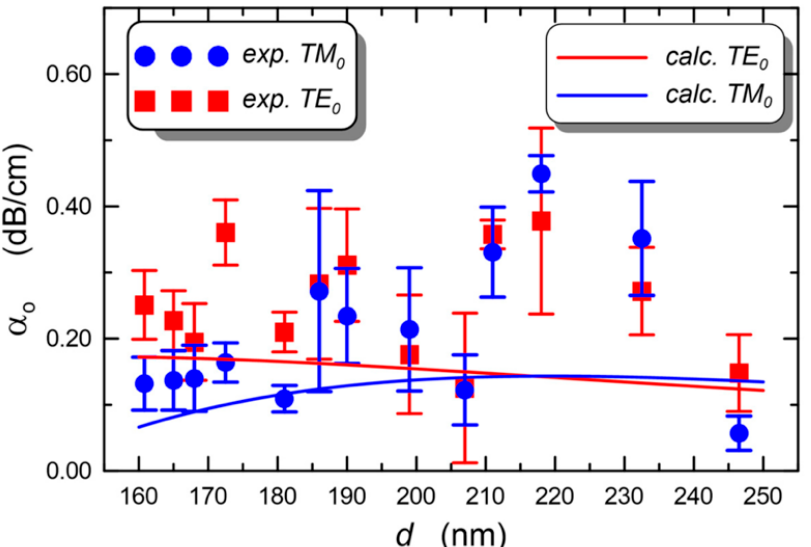
Figure 5. Experimental and calculated loss of fundamental TE and TM modes at 677 nm propagating in a silica-titania sol–gel single-mode waveguide deposited onto a BK7 substrate, as a function of the layer thickness. Reproduced from [59] under a Creative Commons license.